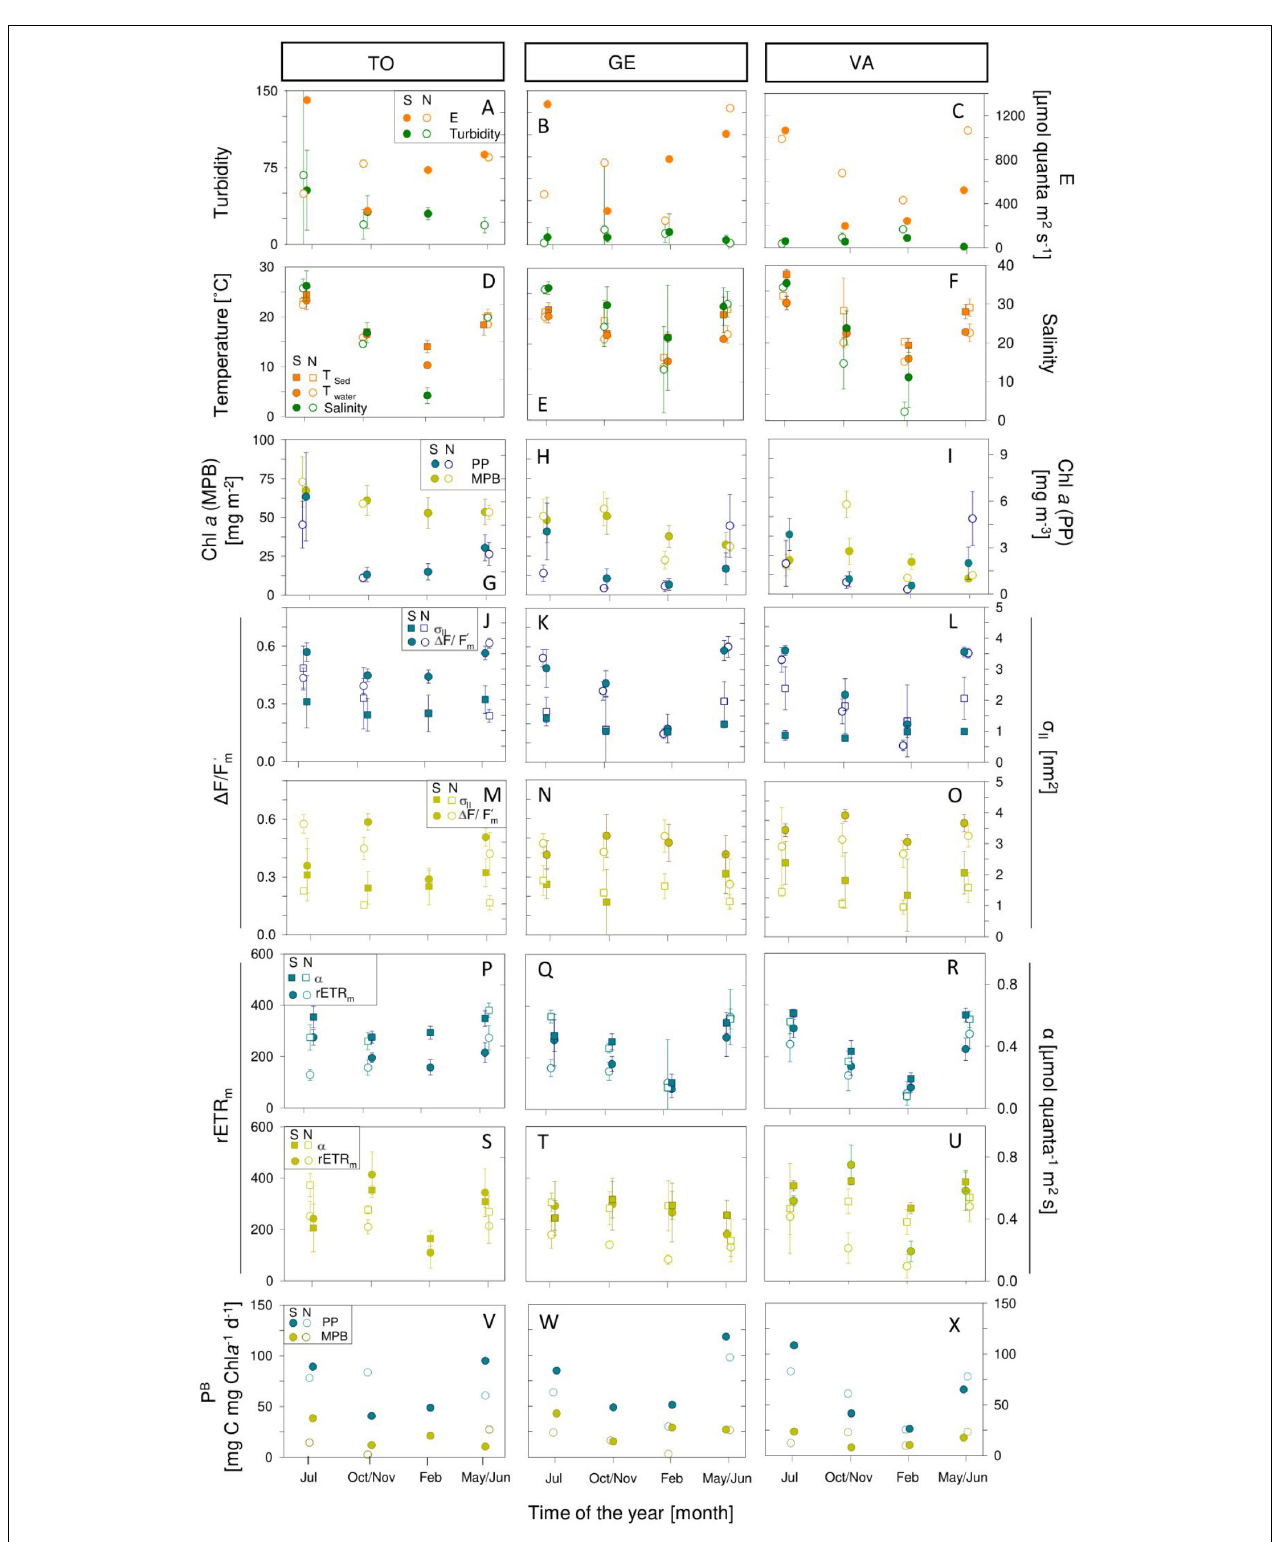
FIGURE 6 | Seasonal variation of abiotic (A–F) and photophysiological (G–X) parameters in sampling sites Torreira (TO; A,D,G,J,M,P,S,V) , Gafanha da Encarnação (GE; B,E,H,K,N,Q,T,W ) and Vista Alegre (VA; C,F,I,L,O,R,U,X ) during spring (full circles) and neap tide (empty circles), for phytoplankton (blue) and microphytobenthos (yellow). Mean values of three replicates. Error bars represent one standard error. PP, phytoplankton; MPB, microphytobenthos.